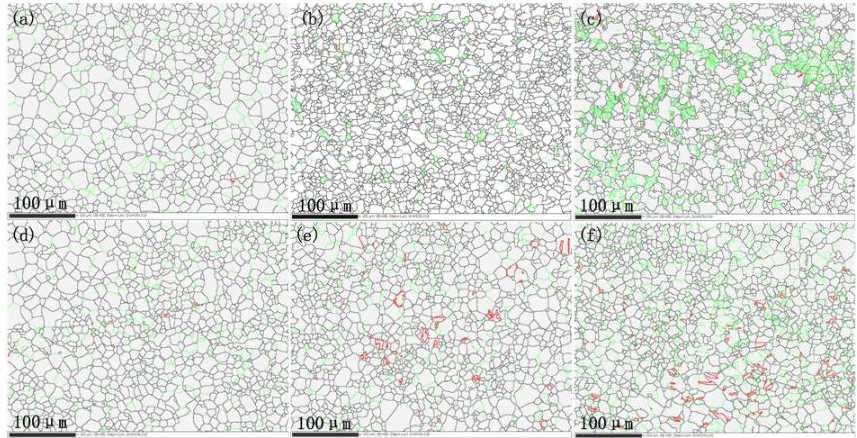
Figure 3. The grains change during cyclic loading: ( a ) As-received material; ( b ) cycles at 1000; ( c ) cycles at 5000; ( d ) cycles at 10,000; ( e ) cycles at 20,000; ( f ) cycles at 30,000.